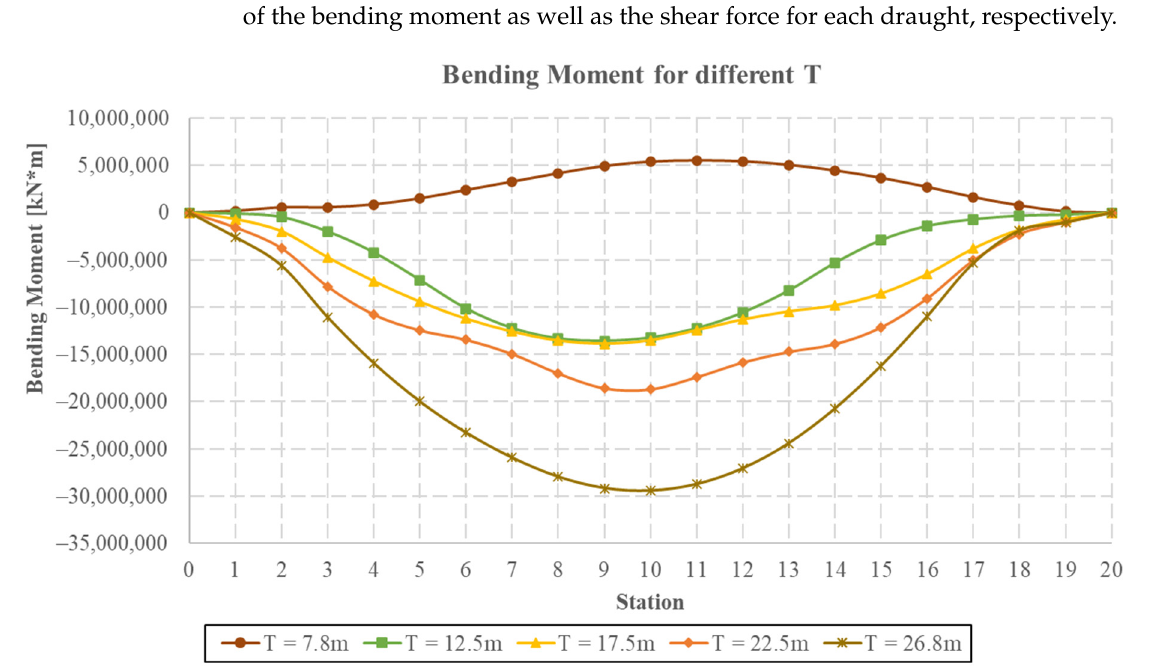
Figure 3. Bending moment distribution for different draughts.